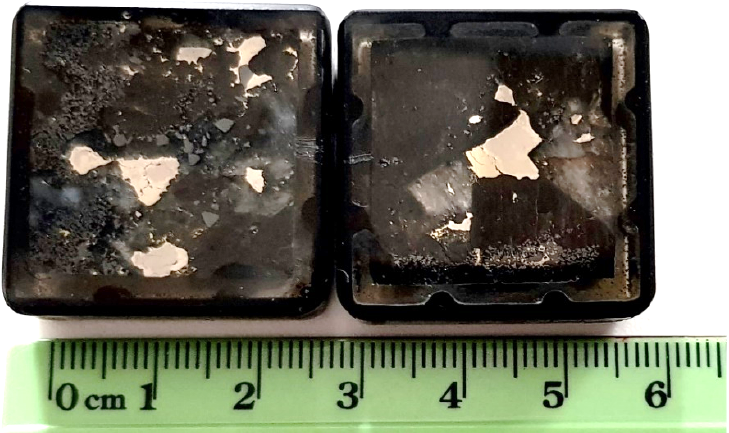
Figure 2. Example of the studied polished blocks from the Merensky Reef, showing the sulfide blebs (creamy–yellow) and the cumulitic chromitite (small polygonal dark grey grains) in the pegmatoidal feldspathic pyroxenite.